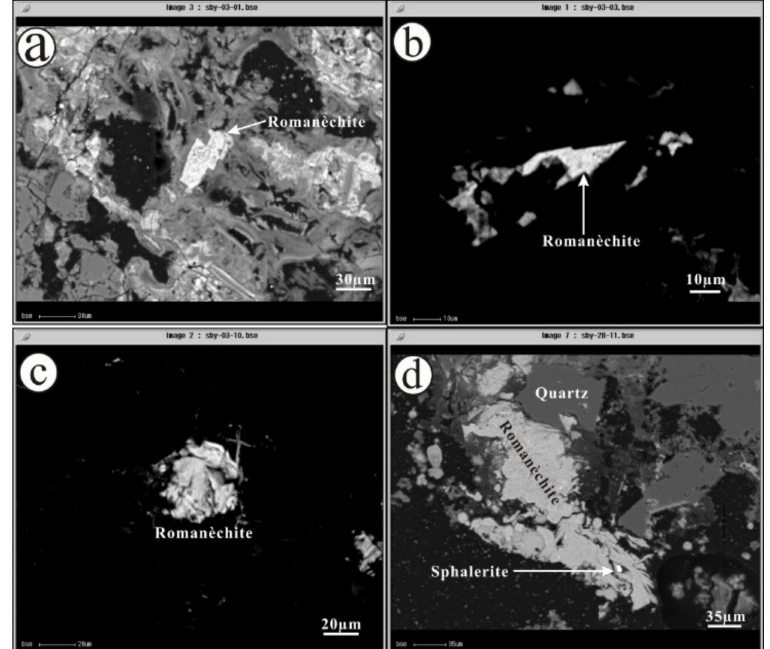
Figure 10. BSE images of roman è chite from the Sanbao deposit: ( a ) single crystal of roman è chite; ( b ) Ag-rich roman è chite; ( c ) colloidal roman è chite with complex composition; ( d ) sphalerite inclusion in roman è chite.